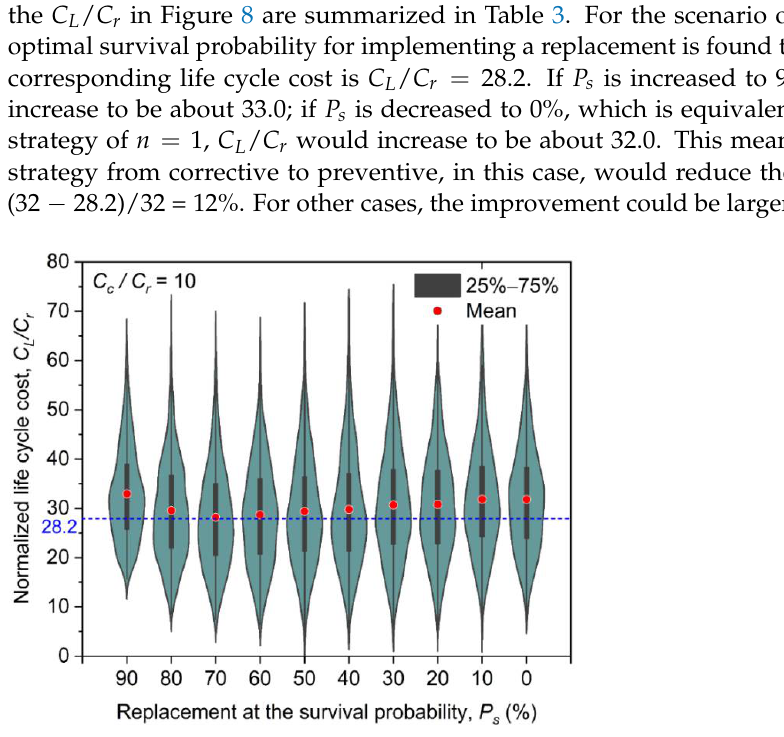
Figure 8. Normalized life cycle cost C L / C r varying with replacement at the survival probability of Figure 8. Normalized life cycle cost (cid:1829) (cid:3013) /(cid:1829) (cid:3045) varying with replacement at the survival probability of Figure 8. Normalized life cycle cost (cid:1829) (cid:3013) /(cid:1829) (cid:3045) varying with replacement at the survival probability of water mains ( (cid:1856) = 5% , (cid:2009) = 0.1 , (cid:2010) = 0.6 , and (cid:2011) = −0.3 ). water mains ( d = 5%, α = 0.1, β = 0.6, and γ = − 0.3 water mains ( (cid:1856) = 5% , (cid:2009) = 0.1 , (cid:2010) = 0.6 , and (cid:2011) = −0.3 ).